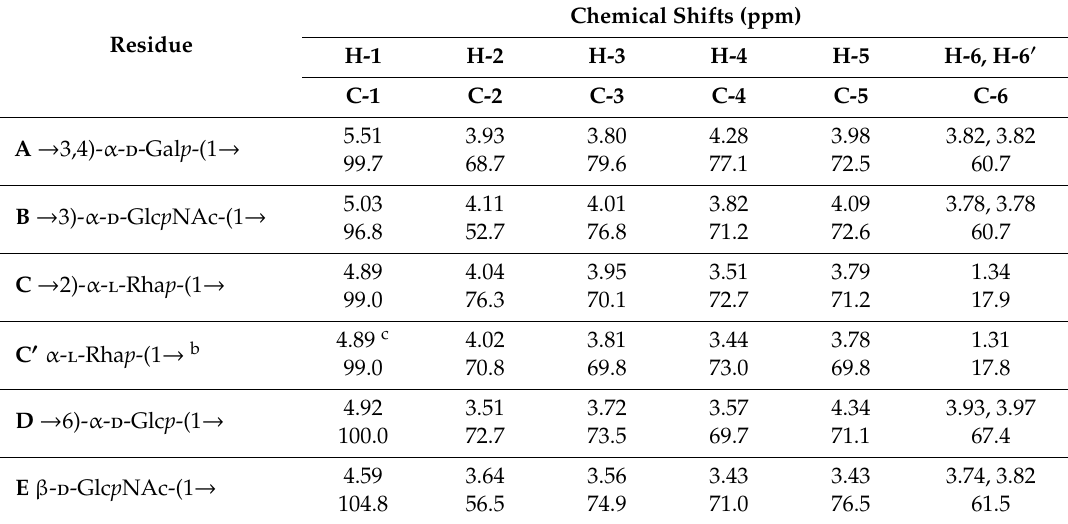
Table 1. 1 H and 13 C NMR chemical shifts of the O-PS of B. holmesii strain ATCC 51541 a .